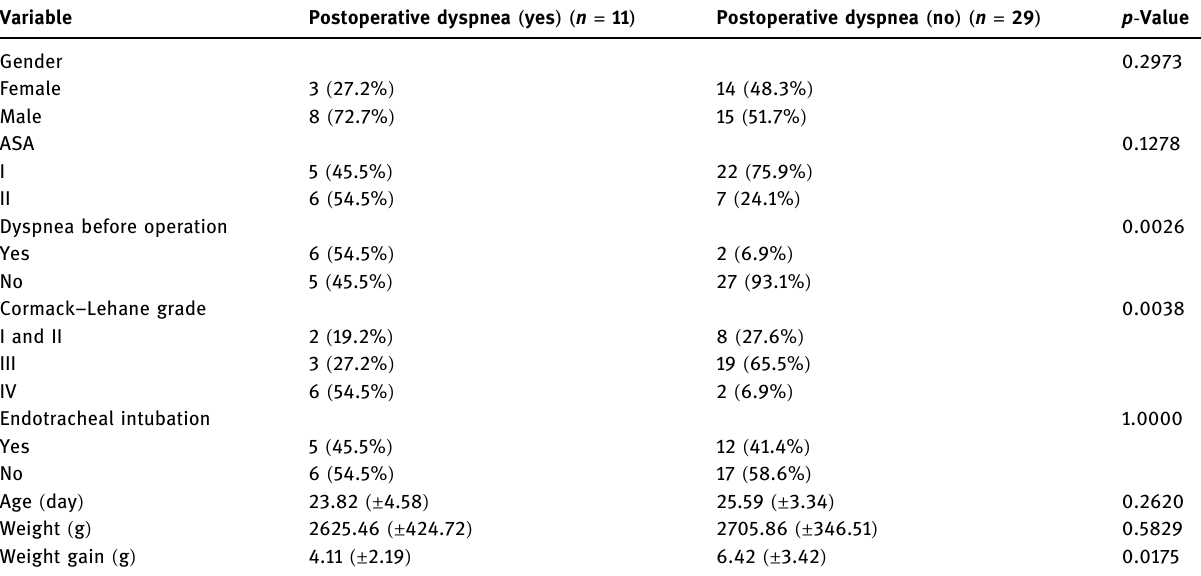
Table 2: Comparison of demographical and clinical data by outcome of postoperative dyspnea